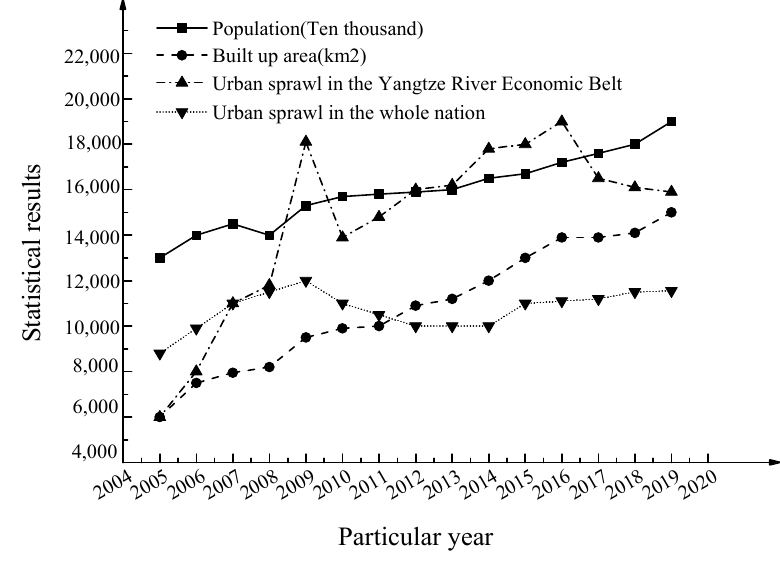
Figure 7. Statistical results of urban sprawl .